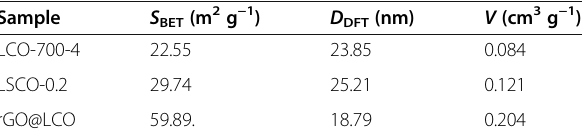
Table 1 Textural parameters of the LCO-700-4, LSCO-0.2 and